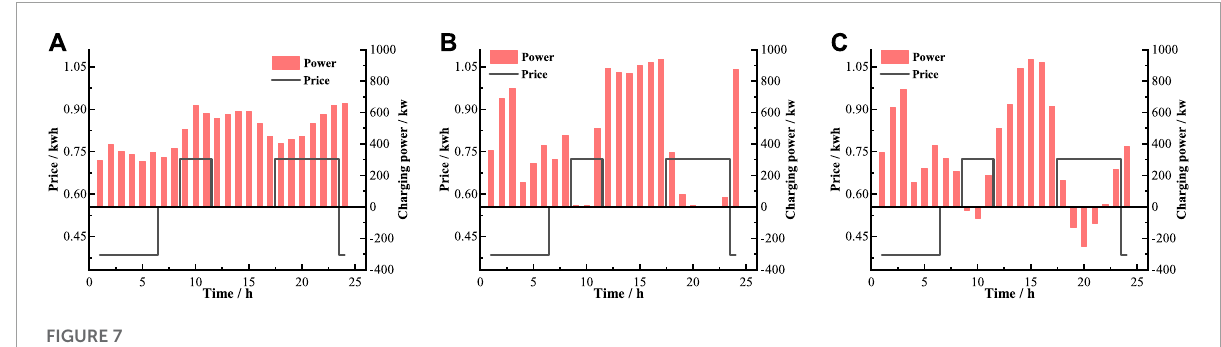
FIGURE 7 Charging or discharging strategies obtained by (A) disorder charging, (B) DDPG, and (C)